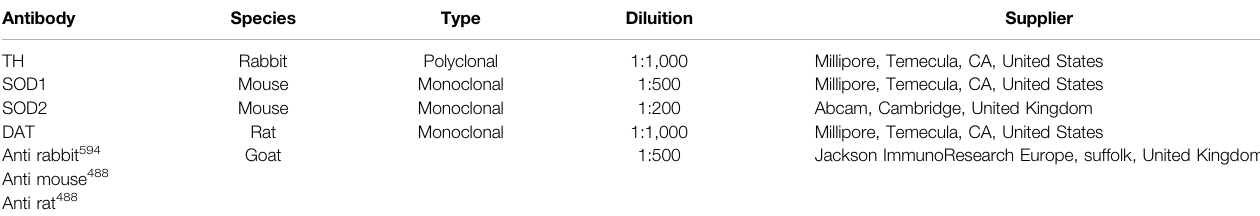
TABLE 1 | Features and dilutions of the primary and secondary antibodies used in this